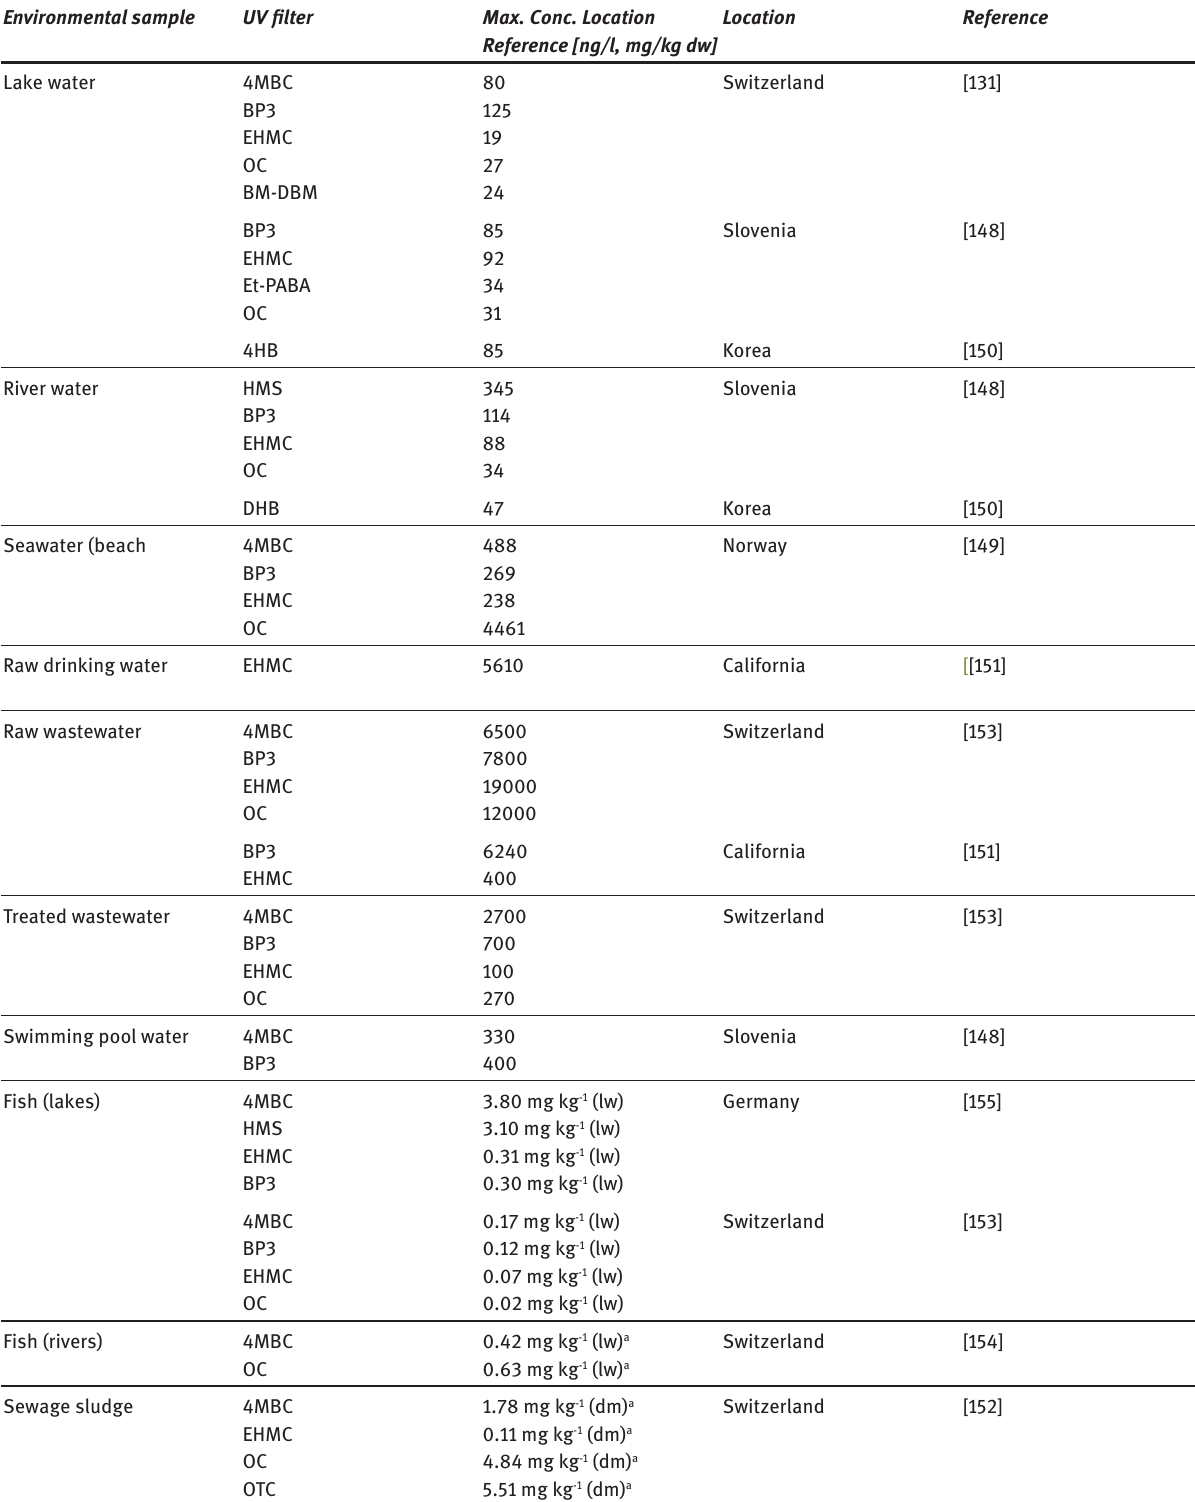
Table 3: Concentrations of UV filters in the environment and biota [134]. Environmental